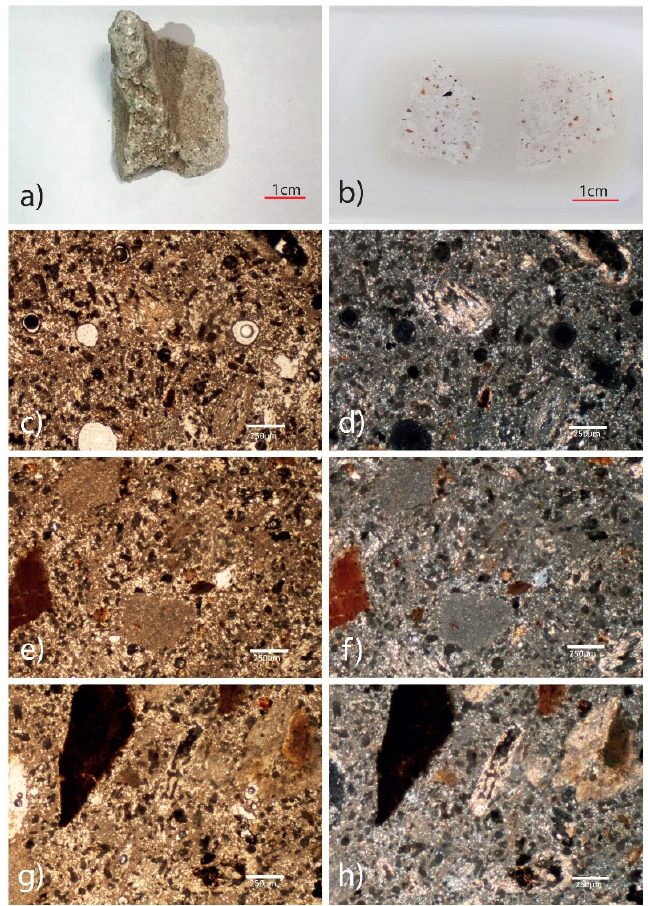
Figure 12. Sample MIN13 (Group H) microphotographs under polarised light microscopy (PL-OM). Mortar with silicatic aggregate and lime/gypsum binder. ( a ) analysed fragment; ( b ) thin section where is visible a fine aggregate (mainly silicatic); ( c ) parallel nicol and ( d ) crossed polars: lime/gypsum binder with silicatic aggregate immersed in the matrix and there is a needle-like mineral species (gypsum); ( e ) parallel polars and ( f ) crossed polars: silicatic aggregate and cocciopesto fragment; ( g ) parallel polars and ( h ) crossed polars: orange cocciopesto and needle ‐ like gypsum crystal (best visible in ( h ).